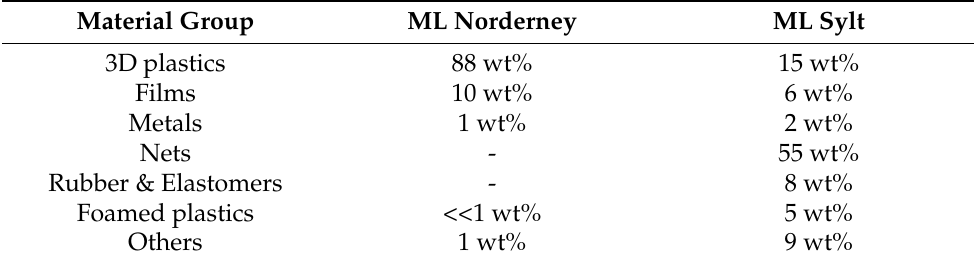
Table 3. Composition of the marine litter (ML) samples used in this study